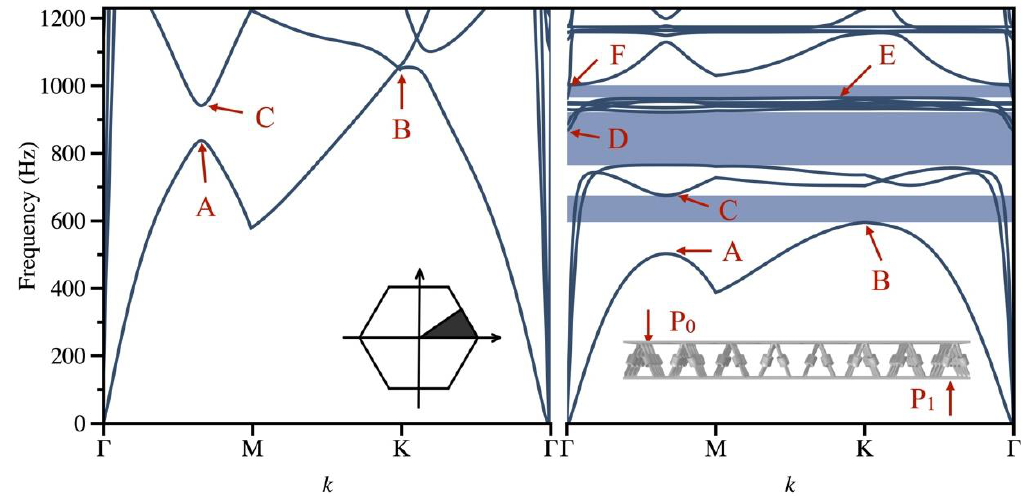
Figure 2. Dispersion curves of the sandwich pyramid lattice core plates without and with resonant rings on the left and right panels, respectively. Inset: The left panel is the first irreducible Brillouin zone, and the right panel is the input/output setting of numerical simulation.